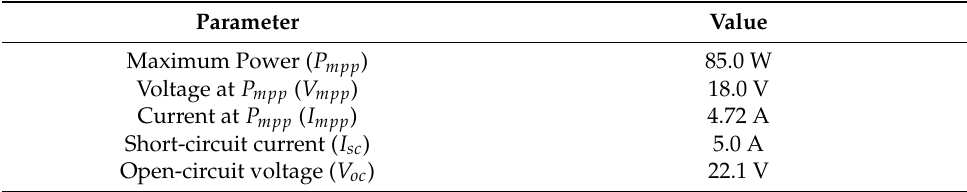
Table 1. Datasheet parameters of the BP585 PV panel